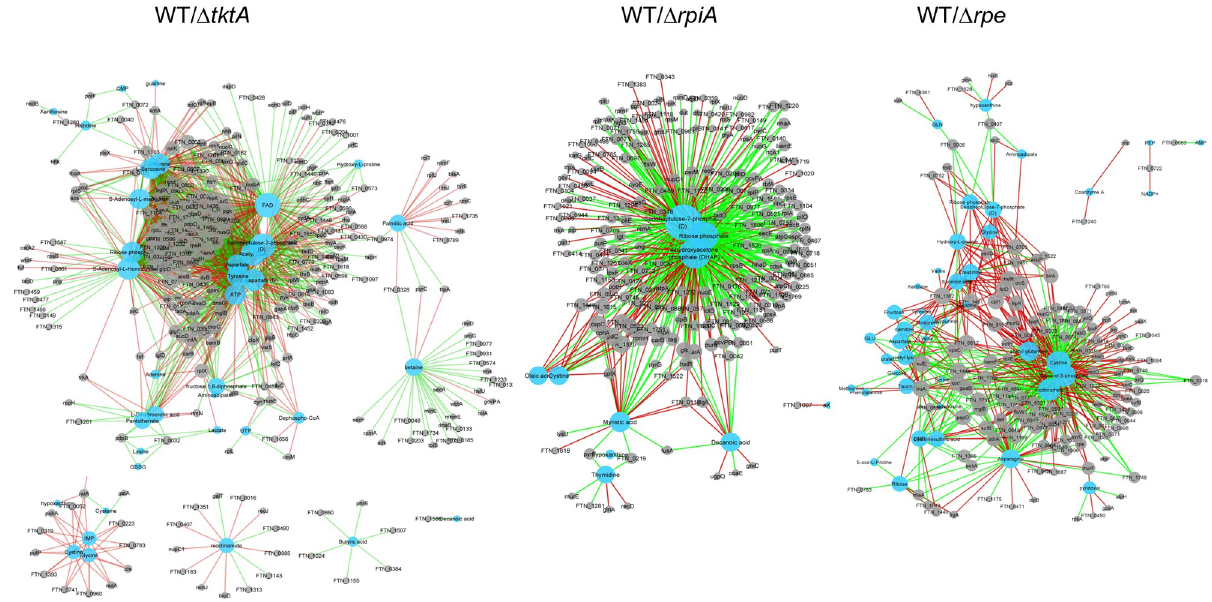
Fig 8. Correlation network derived from rCCA between metabolites and proteins from Francisella . ( A ) WT/ Δ tktA ; ( B ) WT/ Δ rpiA ; ( C ) WT/ Δ rpe .